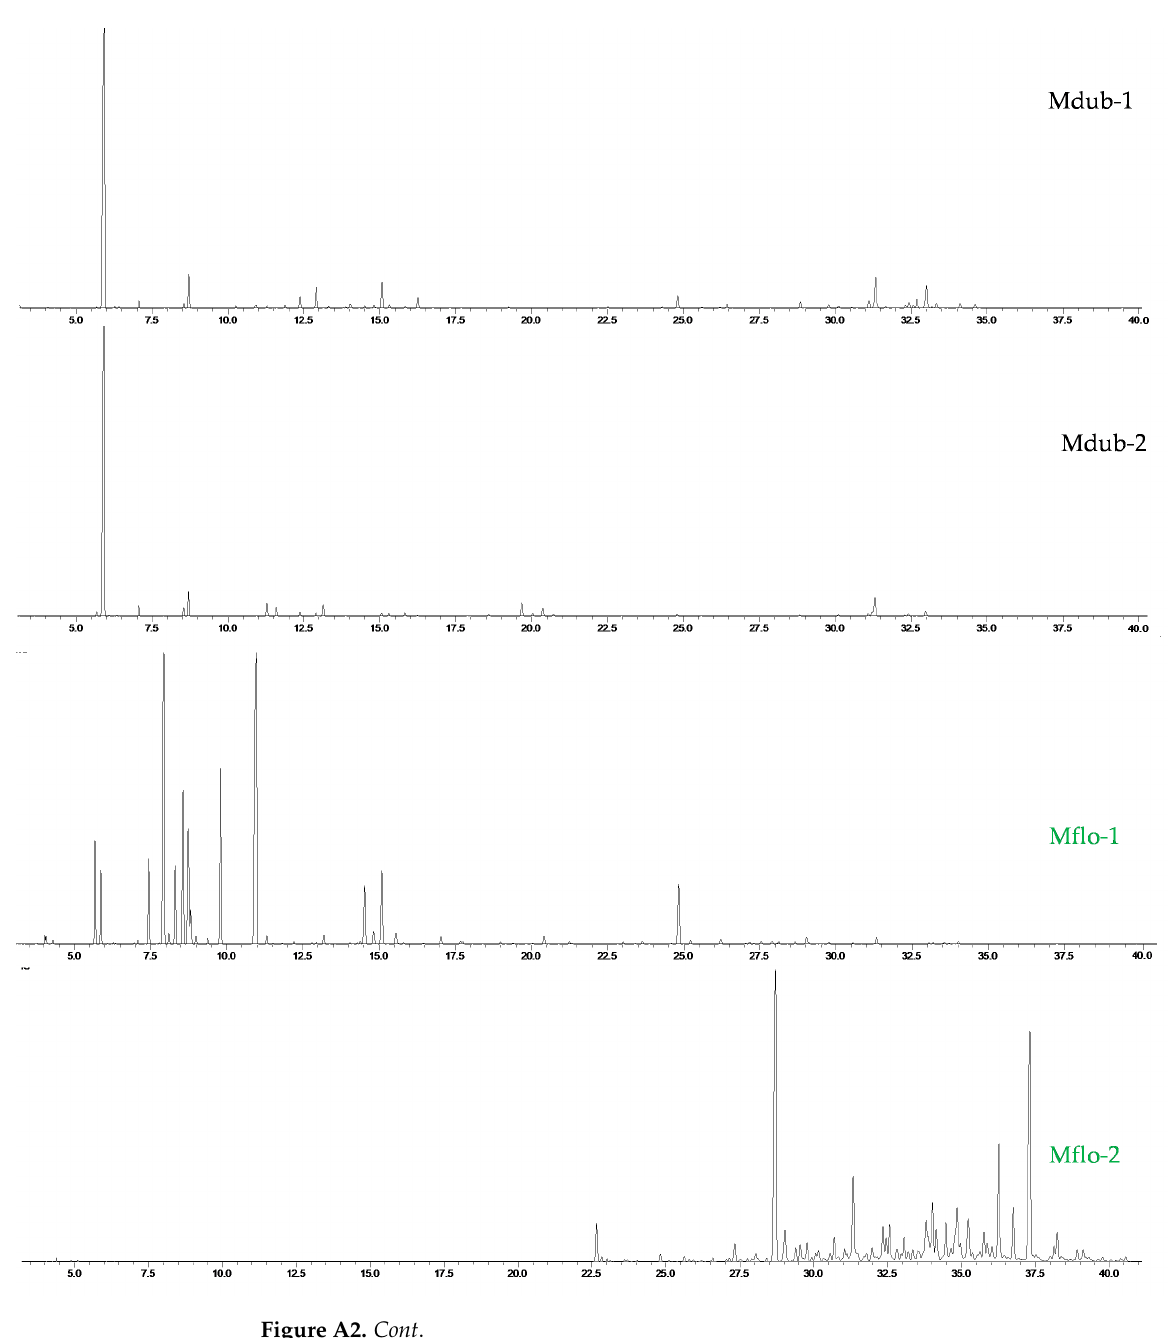
Figure A1. Oxygenated sesquiterpene unidentified MW218.